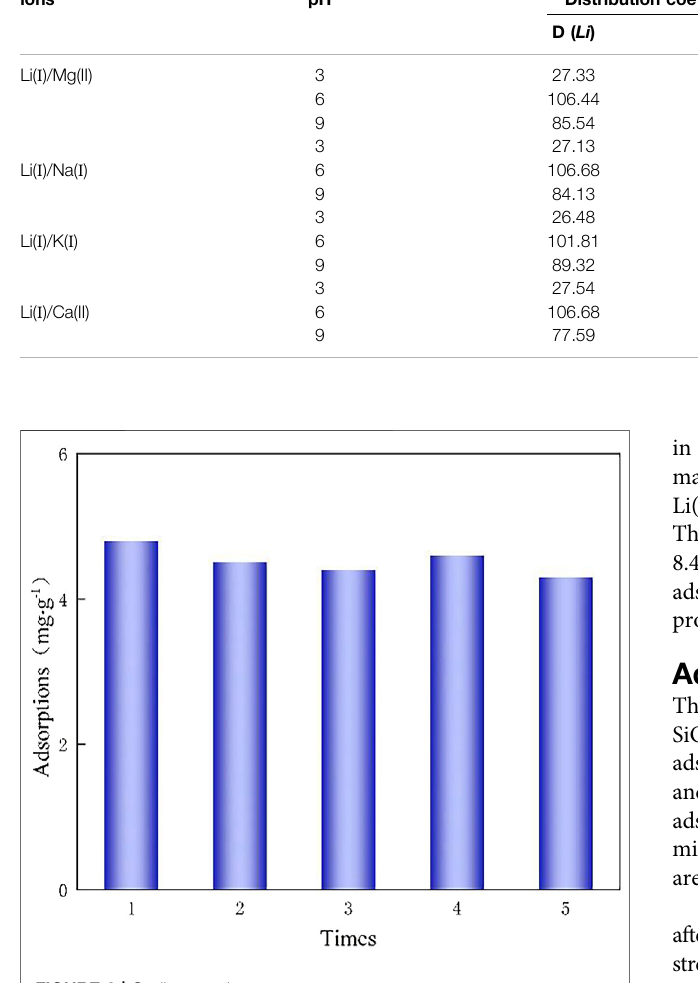
FIGURE 8 | Cyclic